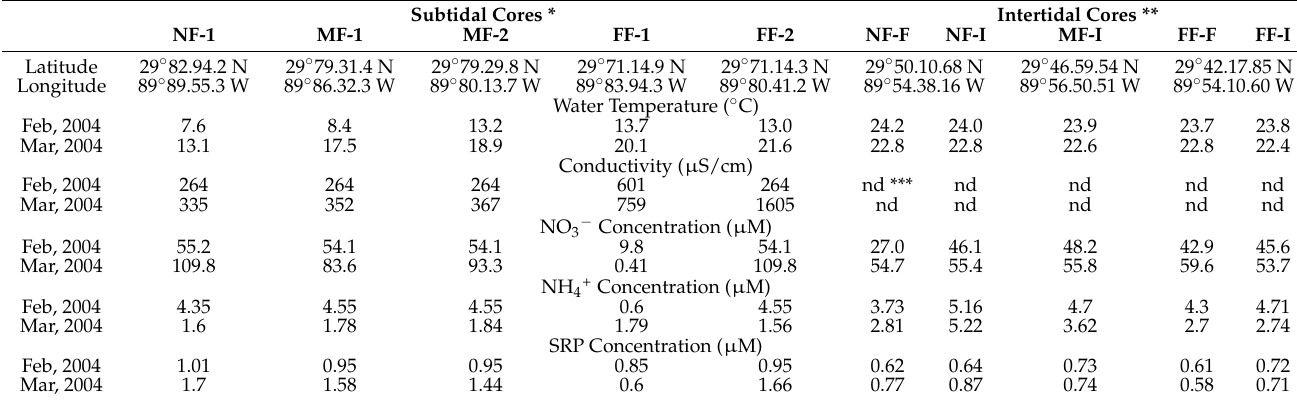
Table 3. Physical and chemical characteristics of the ambient overlying water in the two pulse experiments that subtidal and intertidal cores were incubated to measure benthic fluxes.